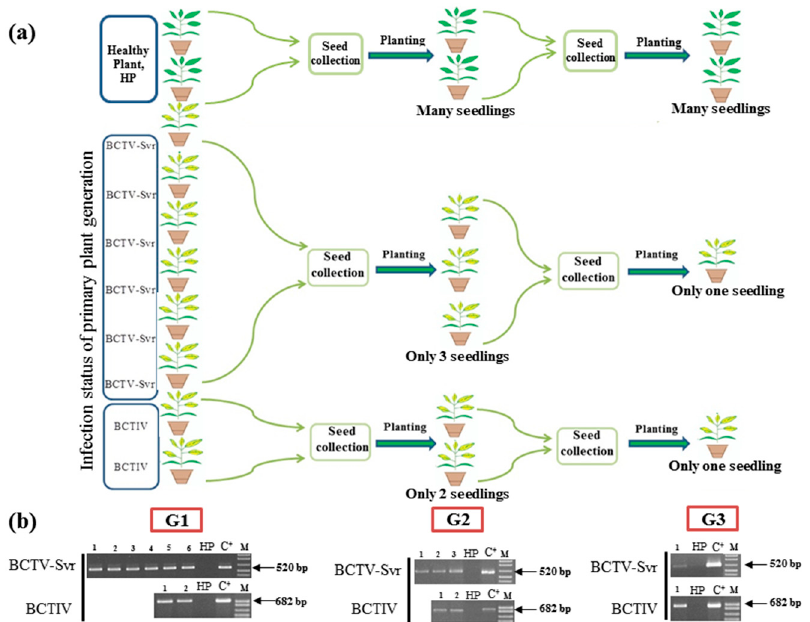
Figure 2. Vertical transmission of BCTV-Svr and BCTIV through three generations of naturally infected petunia plants of local cultivar. ( a ) Schematic representation of an experiment on vertical transmission of BCTV-Svr and BCTIV through three generations (G1, G2 and G3). Healthy plants are shown with green leaves and those from symptomatic infected plants are shown in yellow color; ( b ) agarose gel electrophoresis analysis of PCR products of BCTV-Svr and BCTIV amplified from total DNA extracts from each plant in each generation using specific BCTV-Svr358 V /877 C or BCTIV-474 v /1155 c primer pair. C + = Positive control: cloned DNA of BCTV-Svr (pBin-1.7 BCTV-Svr) or of BCTIV (pBin-1.4-BCTIV). HP = healthy (curly top free) plant. C − = Negative control: distilled water. M = Marker (DNA ladder mix, Fermentas).